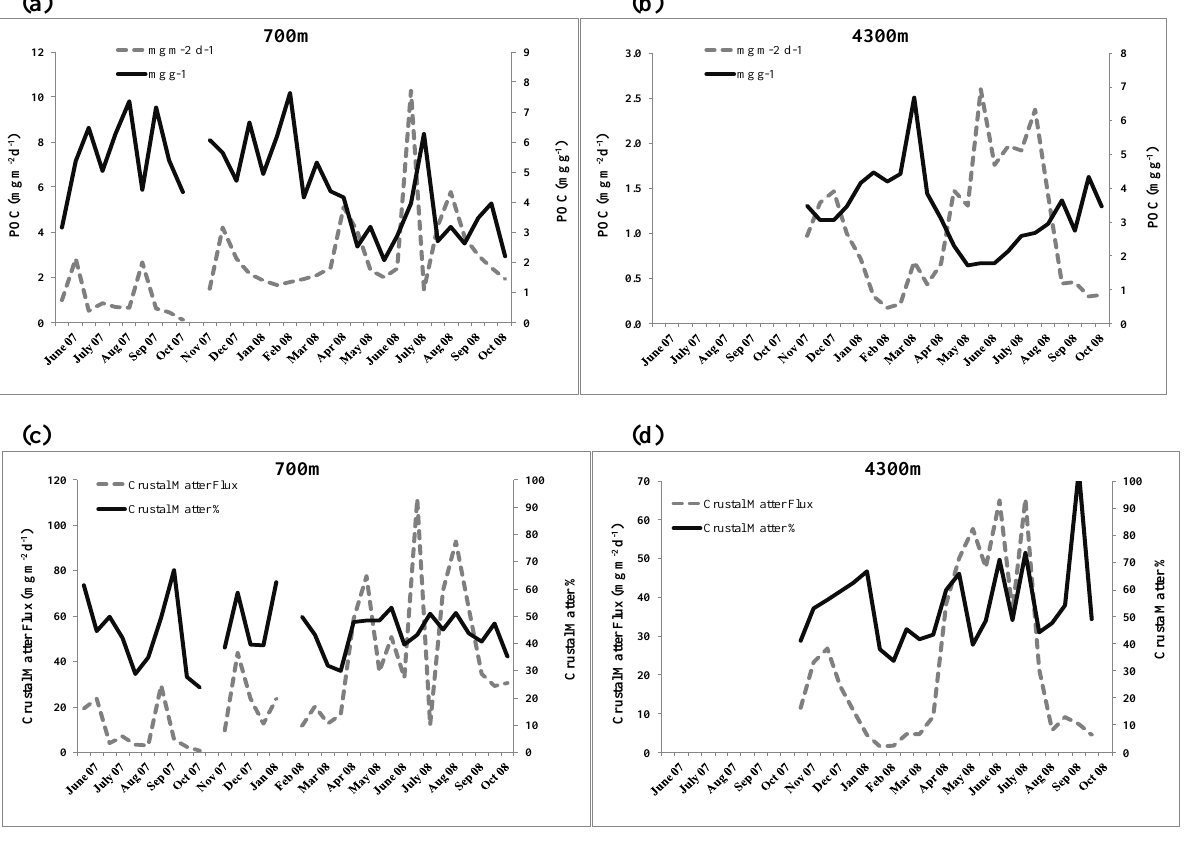
Figure 8. Time series of particulate organic carbon (a, b) in both fluxes (mg m −2 d −1 ) and Fig. 8. Time series of particulate organic carbon ( a , b ) in both fluxes (mgm − 2 d − 1 ) and concentrations (mgg − 1 ) and crustal matter ( c , d ) in both fluxes (mgm − 2 d − 1 ) and percentages (%) at two depths; 700m and concentrations (mg g −1 ) and crustal matter (c, d) in both fluxes (mg m −2 d −1 ) and percentages (%) at two depts.; 700 m and 4300 m.